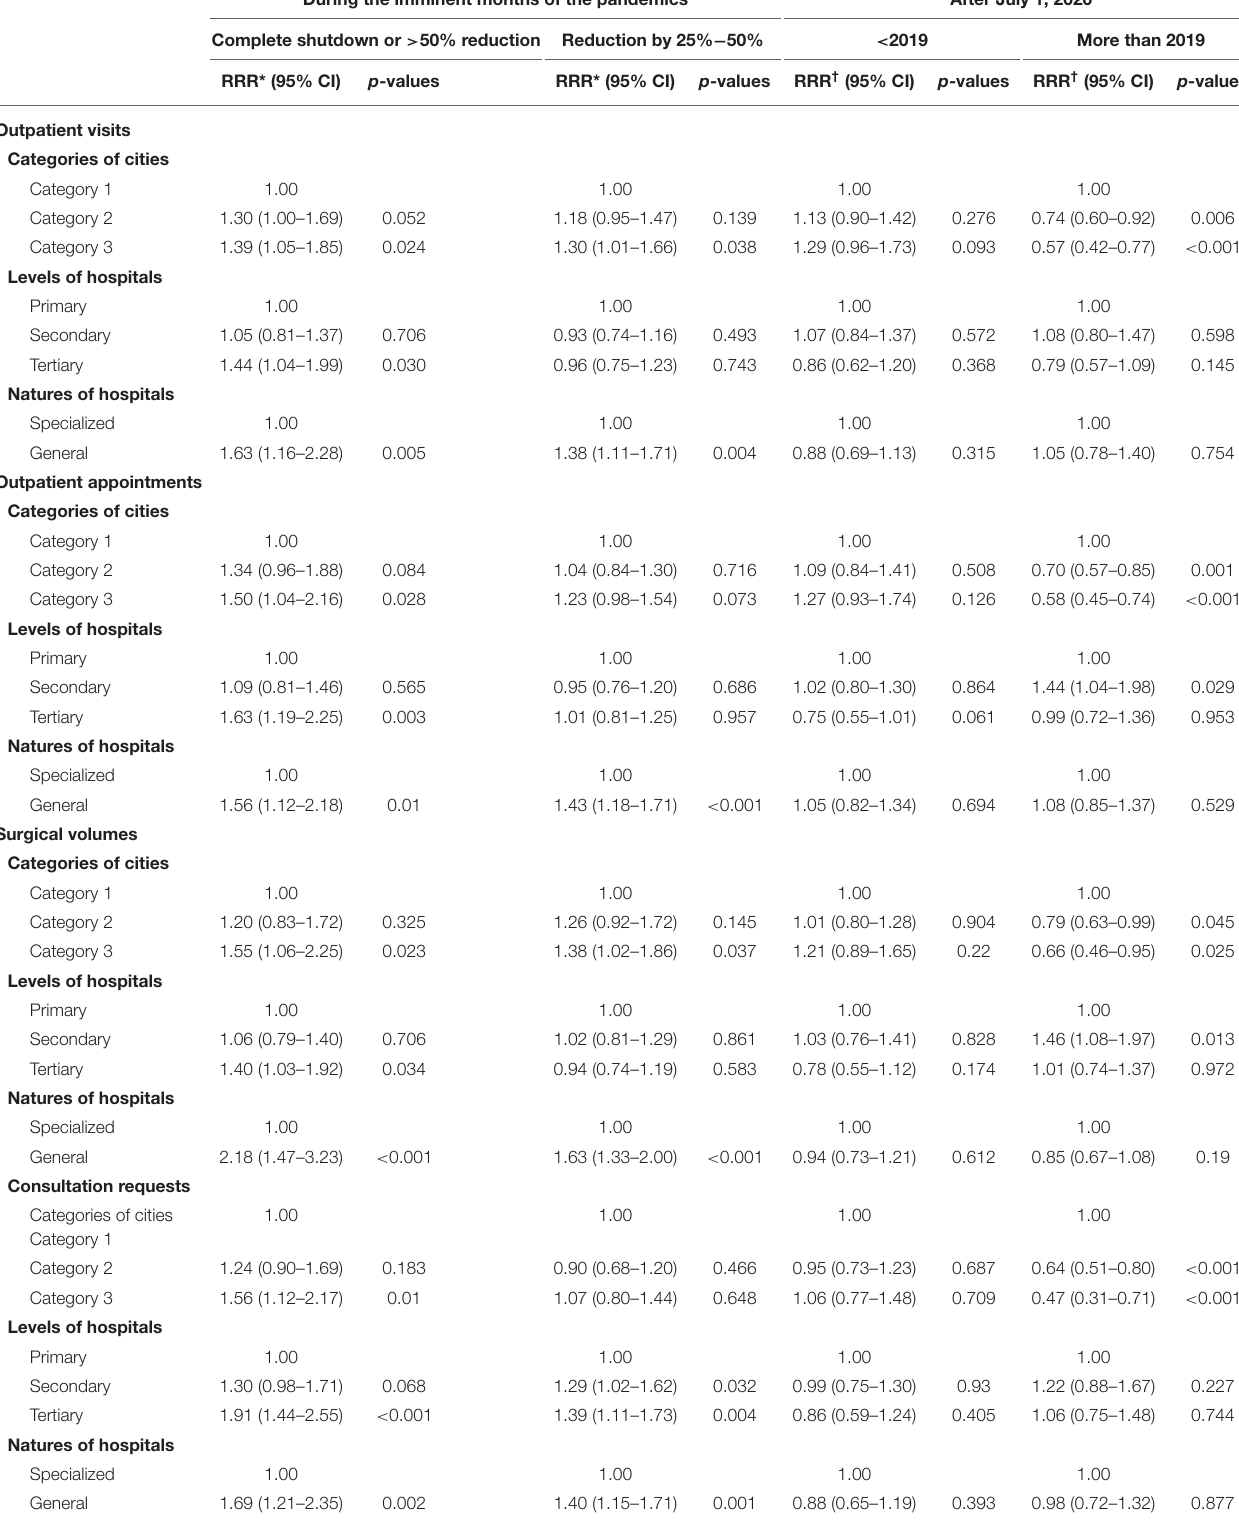
TABLE 3 | Relative risk ratios for the changes in clinical activities estimated from a multivariable regression model adjusted by municipal and hospital